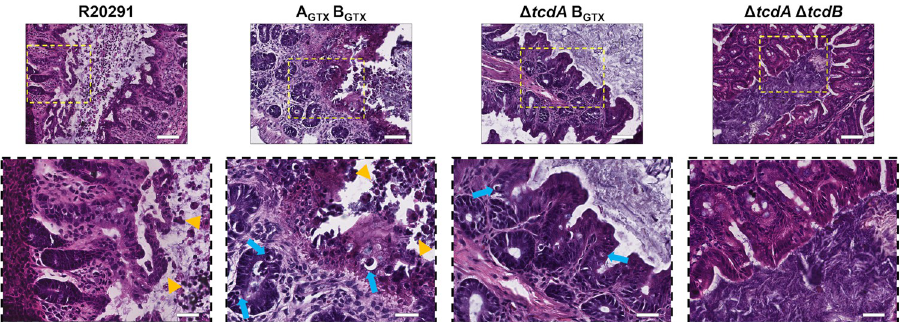
dead cells and pre-pseudomembrane formation is shown by orange arrowheads. Scale bar, 130 μ m.